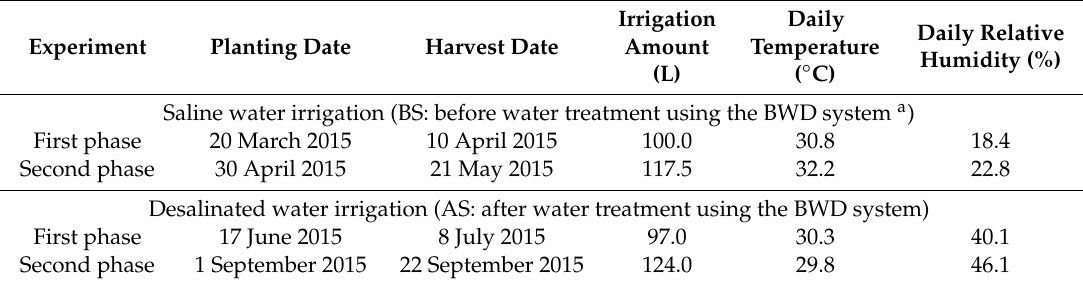
Table 1. Planting and harvesting dates, irrigation amounts and daily averages of temperature and relative humidity for each experimental phase.